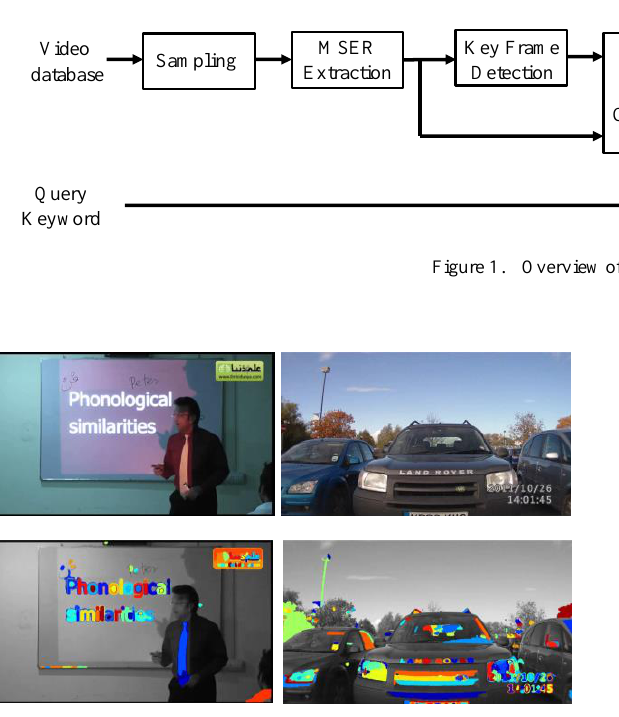
Figure 2. Examples of MSER extraction, (top) original images, (bottom) MSERs shown in different